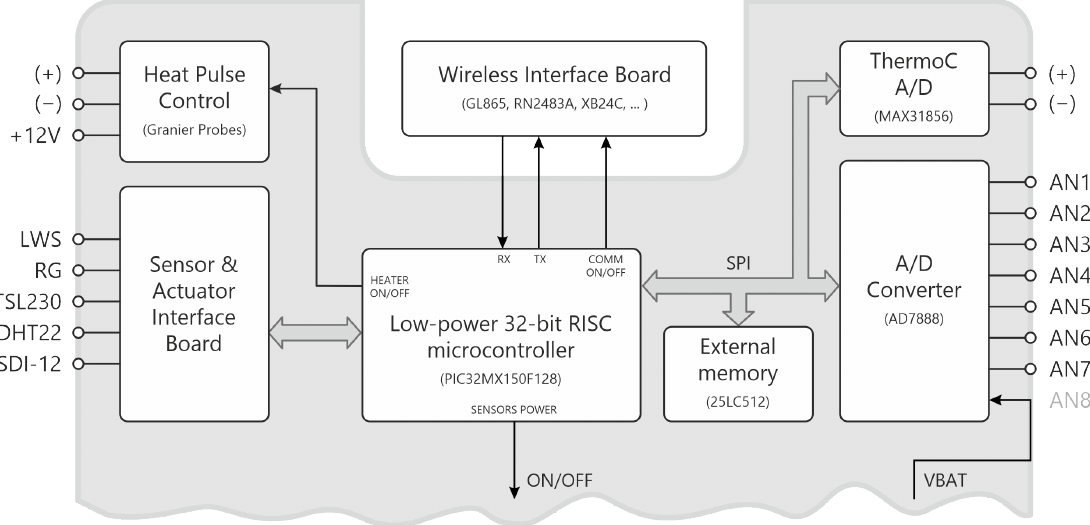
Figure 1. SPWAS’21 simplified system architecture block